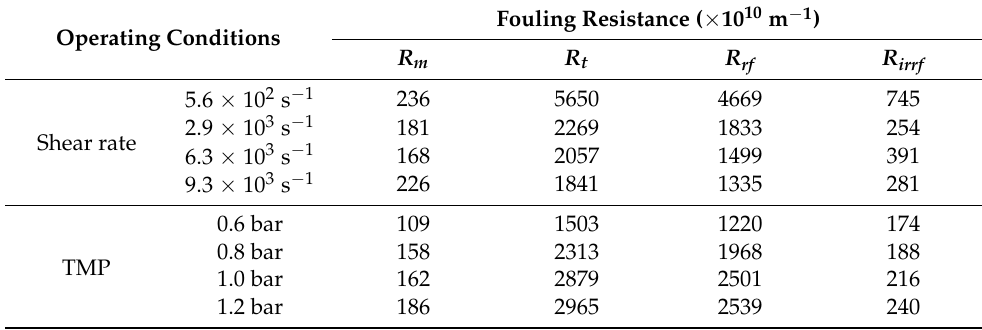
Table 4. Decomposition of fouling resistance in different operating conditions (PVDF 50